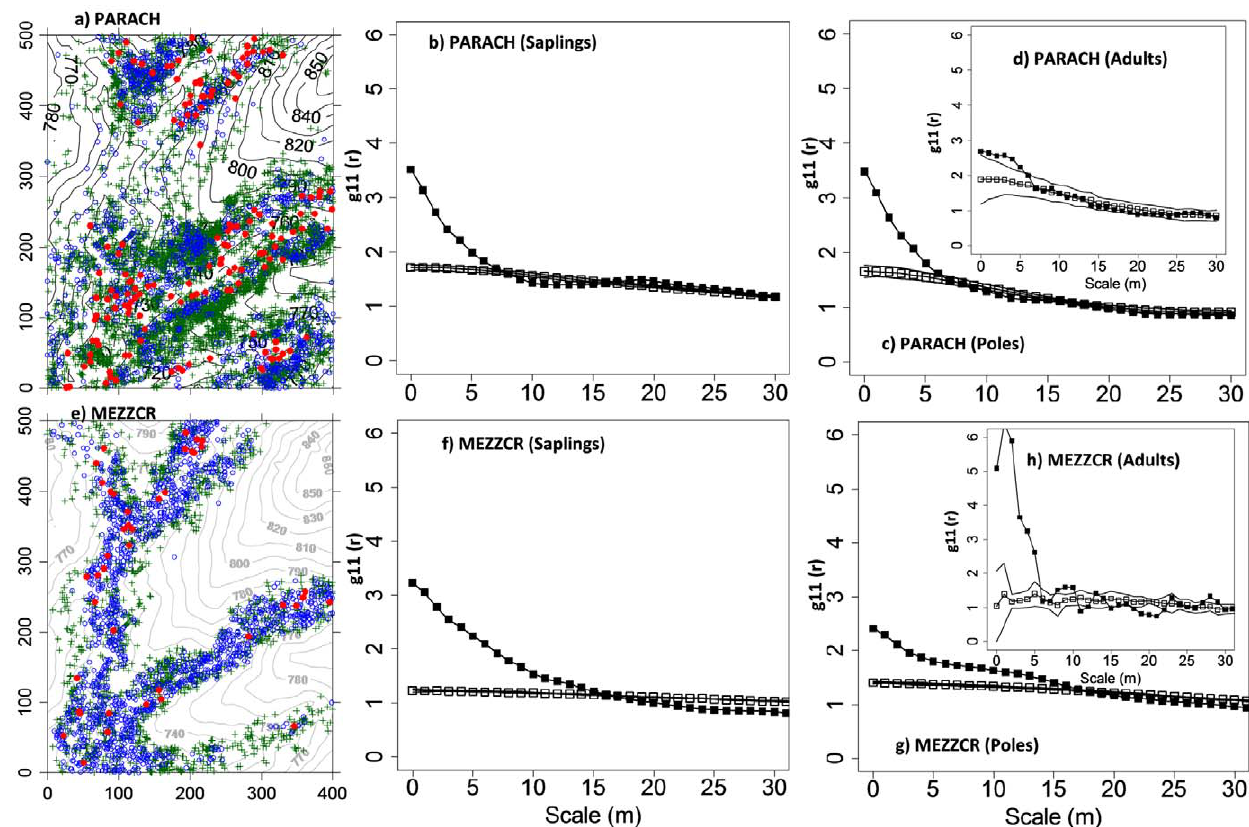
Figure 2. Examples of distribution maps and univariate patterns. Shown are the univariate g 11 pair-correlation functions of the data in dependence on scale r (solid squares), and the expected g 11 (r) function under the heterogeneous Poisson null model (open squares) and the Monte Carlo simulation envelopes (solid lines) of the null models. Monte Carlo confidence was constructed at approximately 95% confidence level (199 simulations). See Table 1 for species codes. Green cross: saplings, blue open circle: poles, red solid circle: adults.